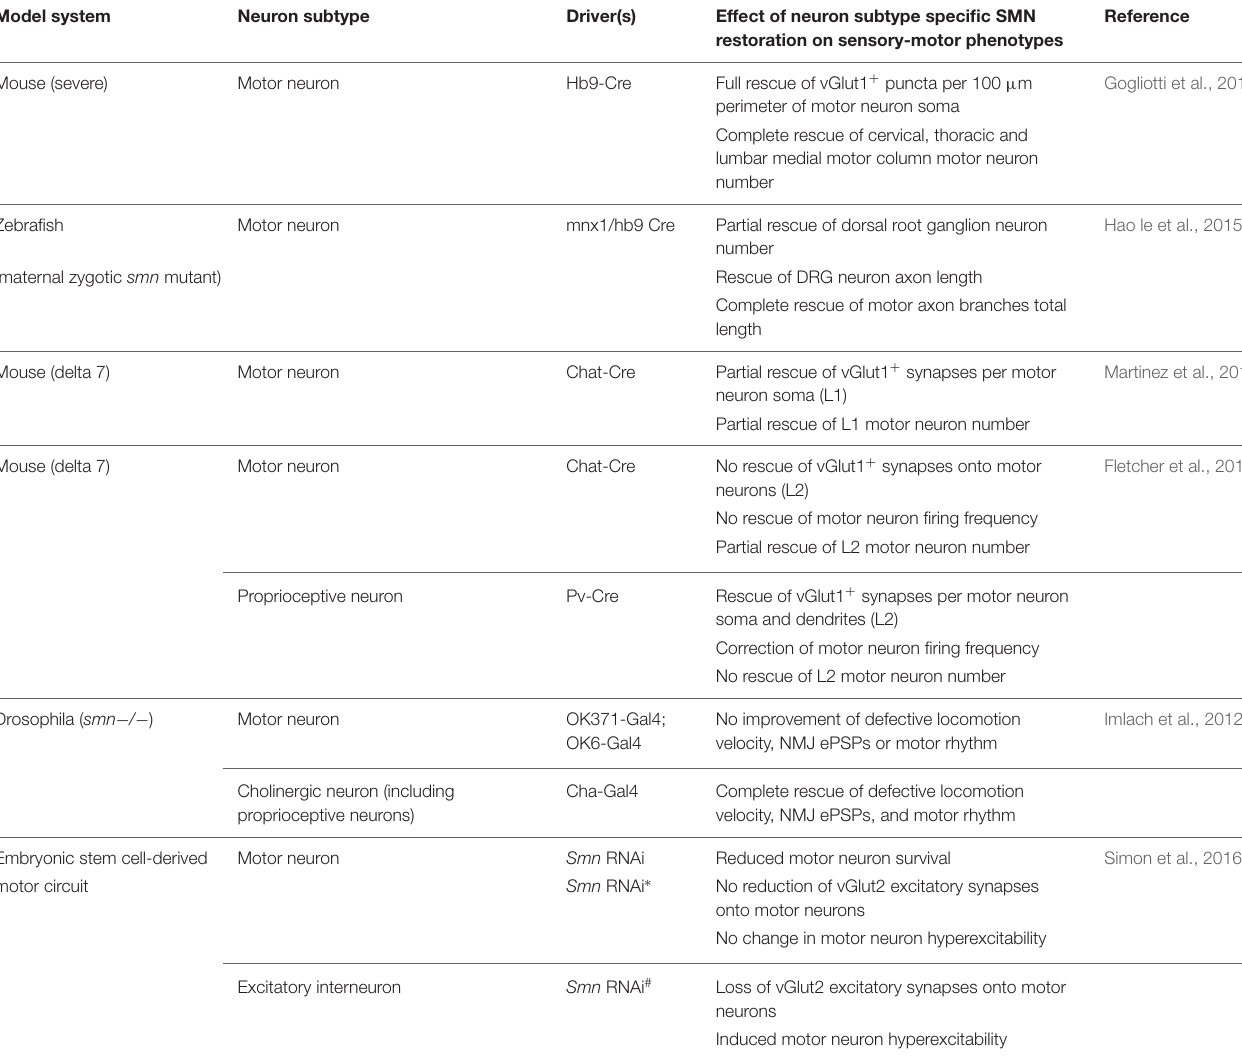
TABLE 1 | Overview of studies investigating SMN expression requirements in various components of the sensory-motor